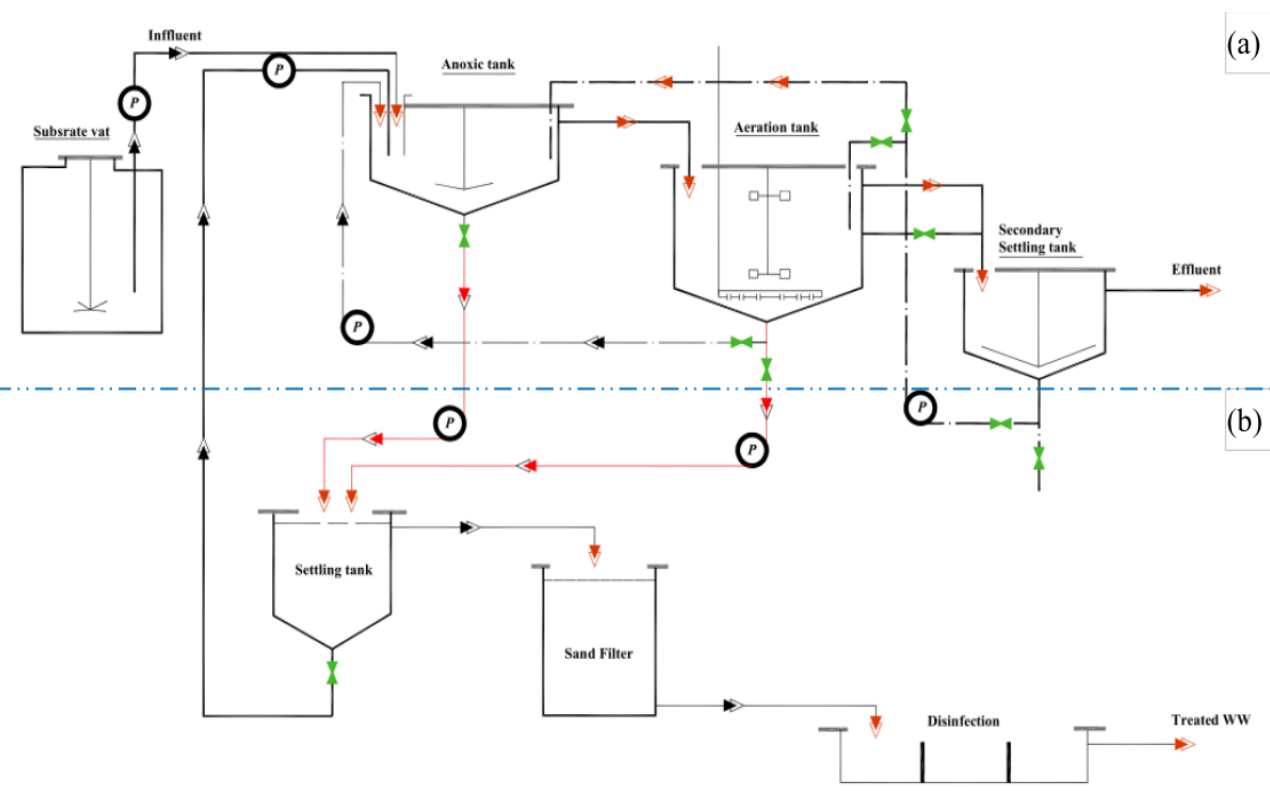
Figure 1. Schematic diagram of the conventional and eco-efficient schemes. ( a ) Conventional acti- vated sludge system; ( b ) eco-efficient activated sludge system.